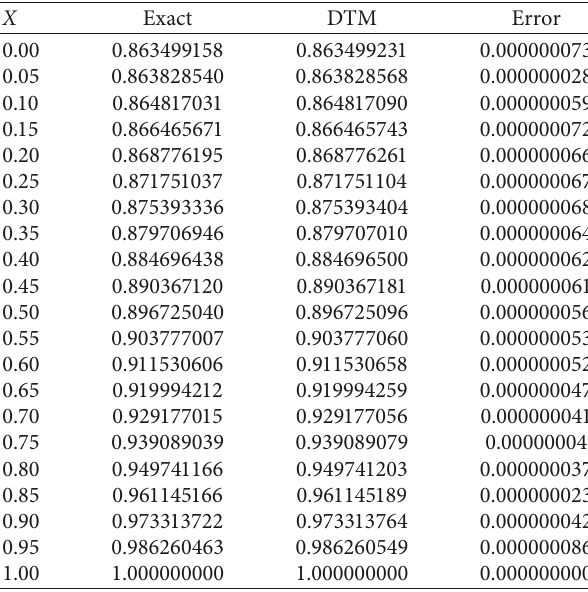
Table 1: Comparison of results when Nc � 0.01, Ma � 0.1, and Nr �